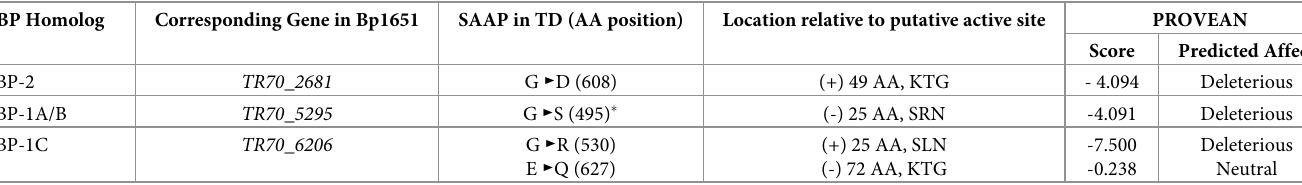
Table 2. Single amino acid polymorphisms found in PBP transpeptidase domains of B . pseudomallei